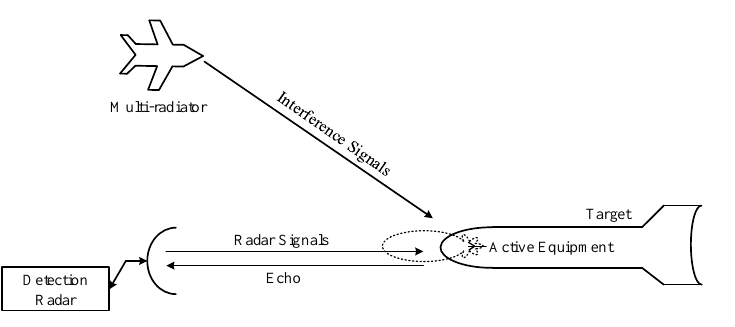
Figure 2. The sketch picture of the multi-radiators problem.